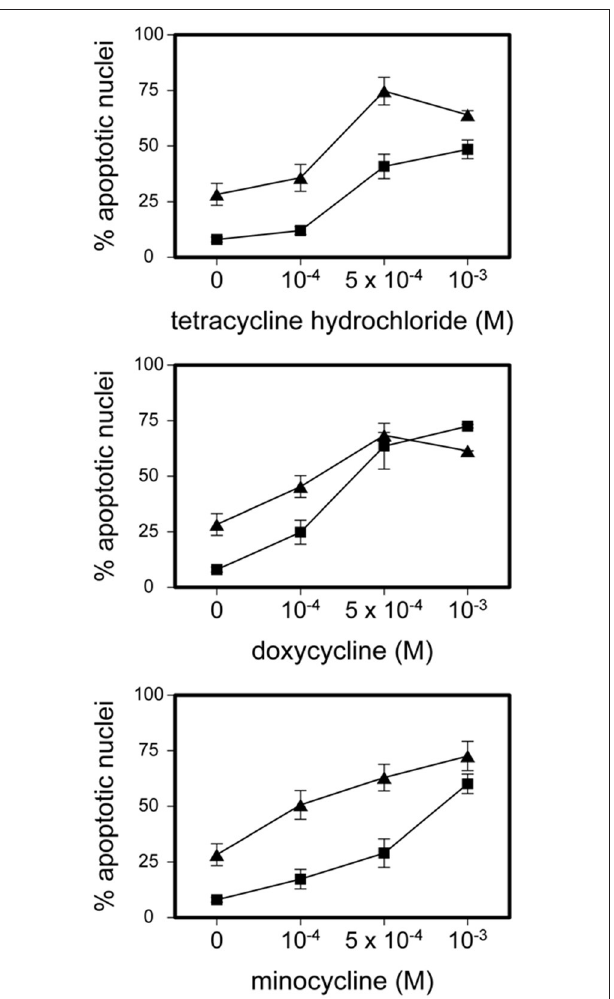
FIGURE 1 | Tetracycline hydrochloride, minocycline and doxycycline induced eosinophil apoptosis. Stimulation of eosinophils with indicated TCNs at 10 − 4 M up to 10 − 3 M for 24h ( (cid:4) ) and 48h ( N ) ( p < 0.05 up to p < 0.001 vs. medium control = 0). Mean percentage of apoptotic nuclei ± SEM ( n = 9). Representative histogram analysis.